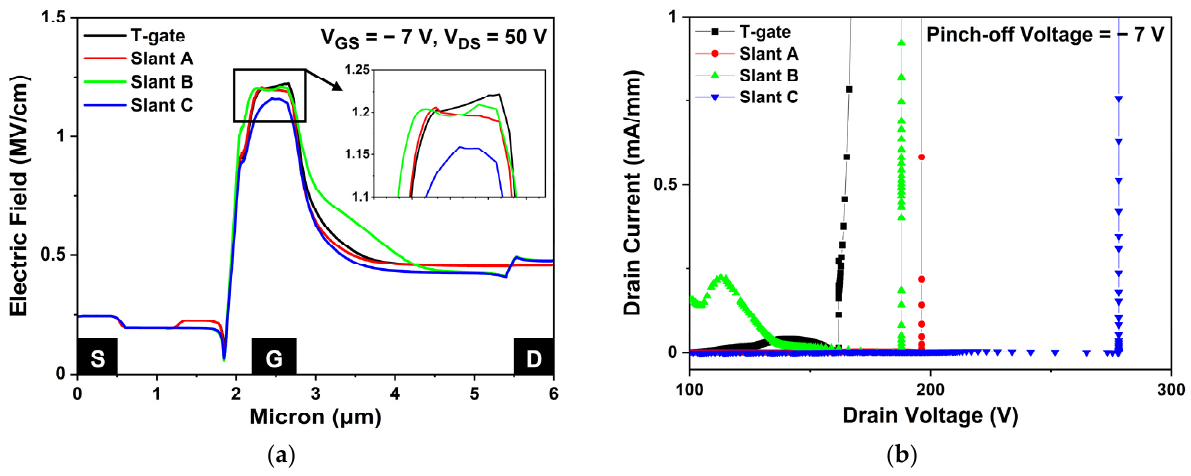
Figure 8. ( a ) Electric field across the two-dimensional electron gas channel layer between source and drain at V GS = − 7 V, V DS = 50 V; ( b ) breakdown characteristics at a pinch-off of V GS = − 7